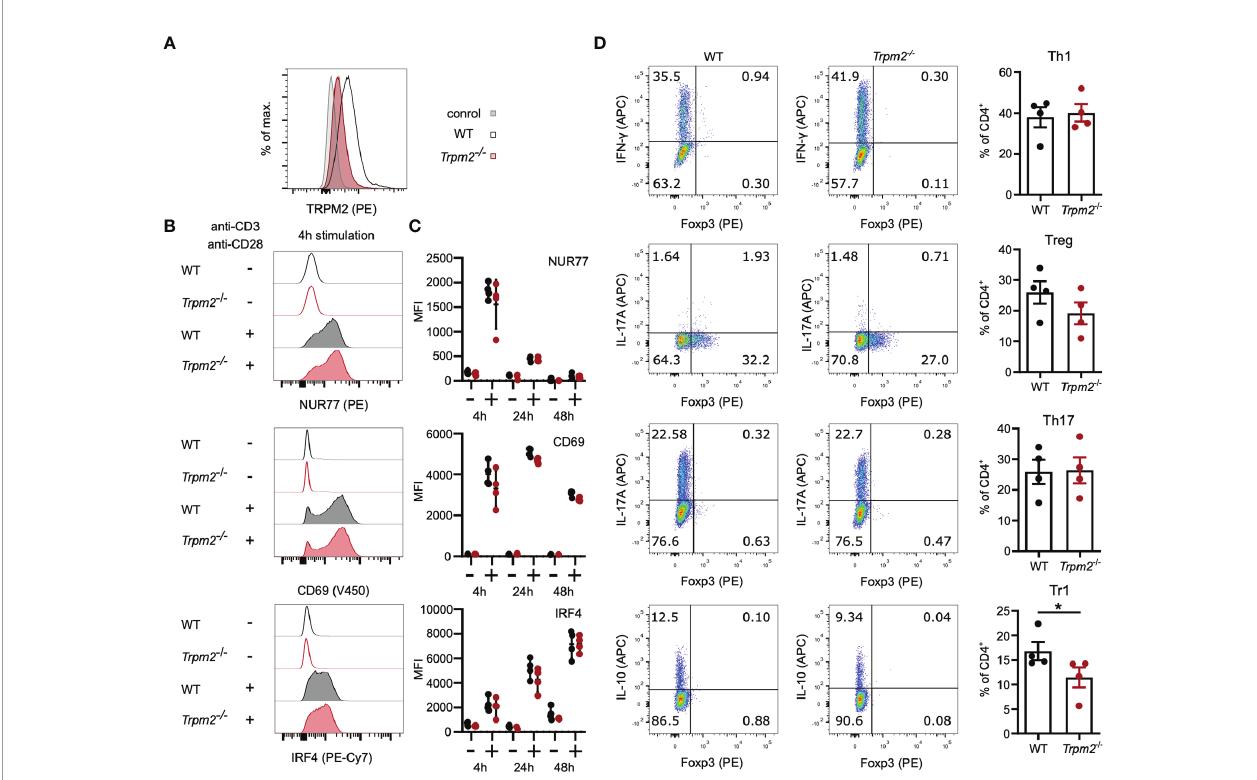
FIGURE 2 | TRPM2 de fi ciency does not impair CD4 + T-cell activation and differentiation in vitro. (A) CD4 + T cells were intracellularly stained with anti-TRPM2 mAb and PE-conjugated anti-rat IgG antibody (control: WT cells stained only with the secondary antibody). (B, C) Spleen cells from WT and Trpm2 -/- mice were stimulated for 4, 24, or 48 h with plate-coated anti-CD3 ϵ mAb and soluble anti-CD28 mAb. Expressions of CD69, NUR77, and IRF4 were determined by extra- and intracellular antibody staining. Representative staining (B) and results (C) for CD4 + T cells are shown. (C) Puri fi ed naïve CD4 + T cells were stimulated with plate-bound anti-CD3 ϵ mAb and soluble anti-CD28 mAb and cultured under Th1-, Th17-, Treg-, and Tr1-polarizing conditions. After 4 days, T cells were stimulated with PMA/ionomycin in the presence of monensin, and cytokine and Foxp3 expression was measured by fl ow cytometry. Shown are representative dot plots and corresponding bar graphs. Th1 cells were de fi ned as IFN- g + CD4 + T cells, Th17 cells as IL-17A + CD4 + T cells, Treg cells as Foxp3 + CD4 + T cells, and Tr1 cells as Foxp3 - IL-10 + CD4 + T cells. Bars and scatters in (C, D) give the mean ± SEM and were analyzed with the unpaired t-test. *p < 0.05. All experiments were conducted at least